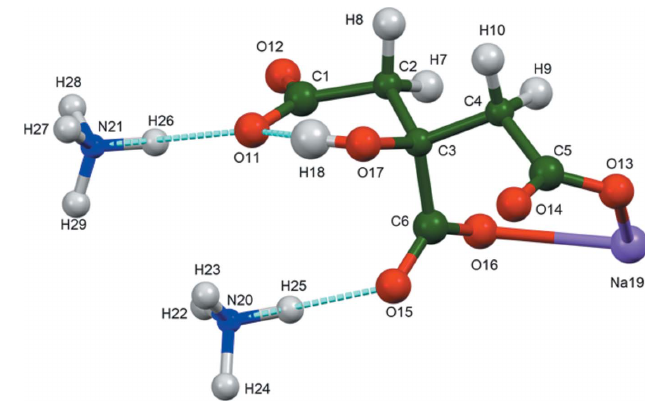
Figure 3 The asymmetric unit of (II) with the atom numbering and 50% probability spheres.